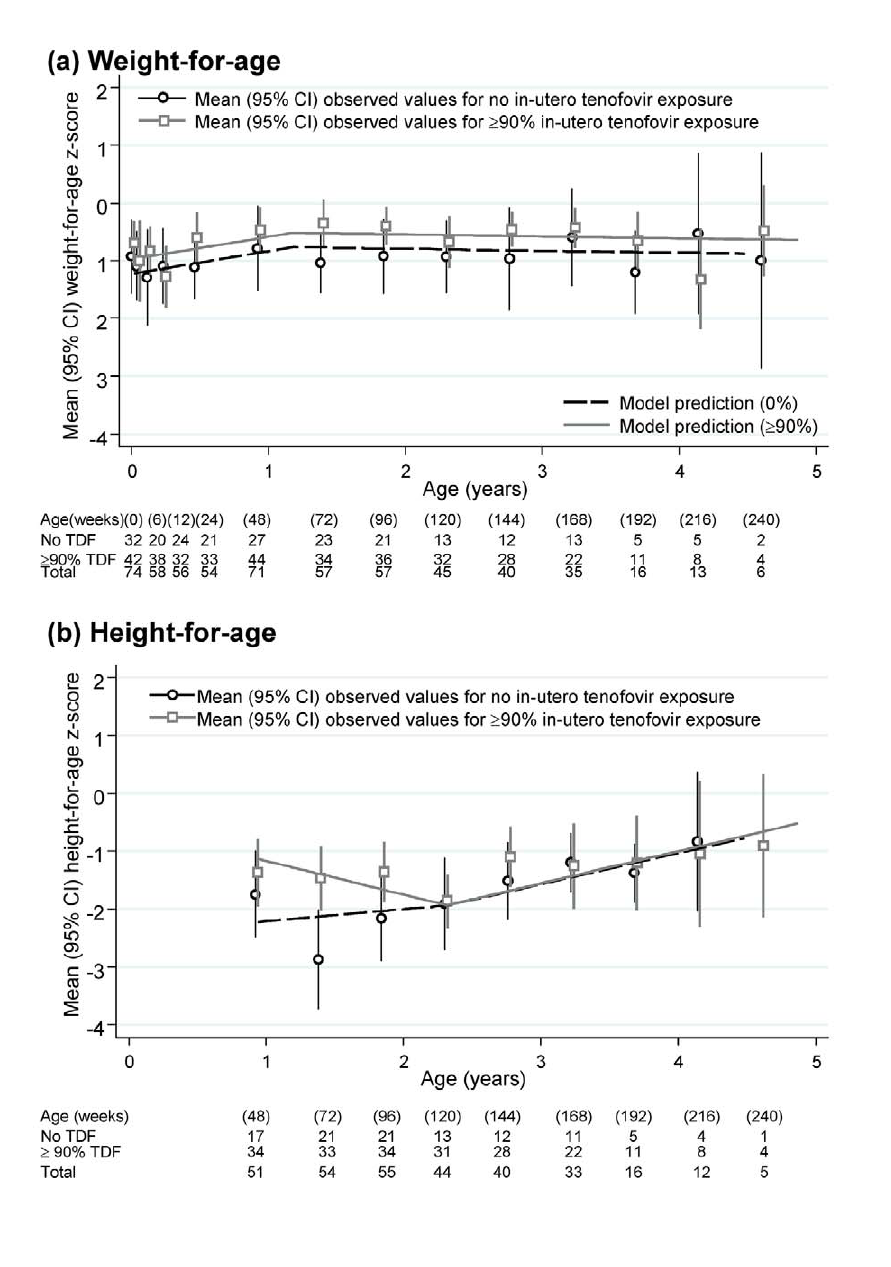
Figure 2. Height-for-age and weight-for-age z-scores in infants born to HIV-infected mothers taking ART. Numbers and mean (95% CI) based on the closest measurement per child to scheduled visit weeks, which were at 6, 12, 24 wk, and then 24-weekly.